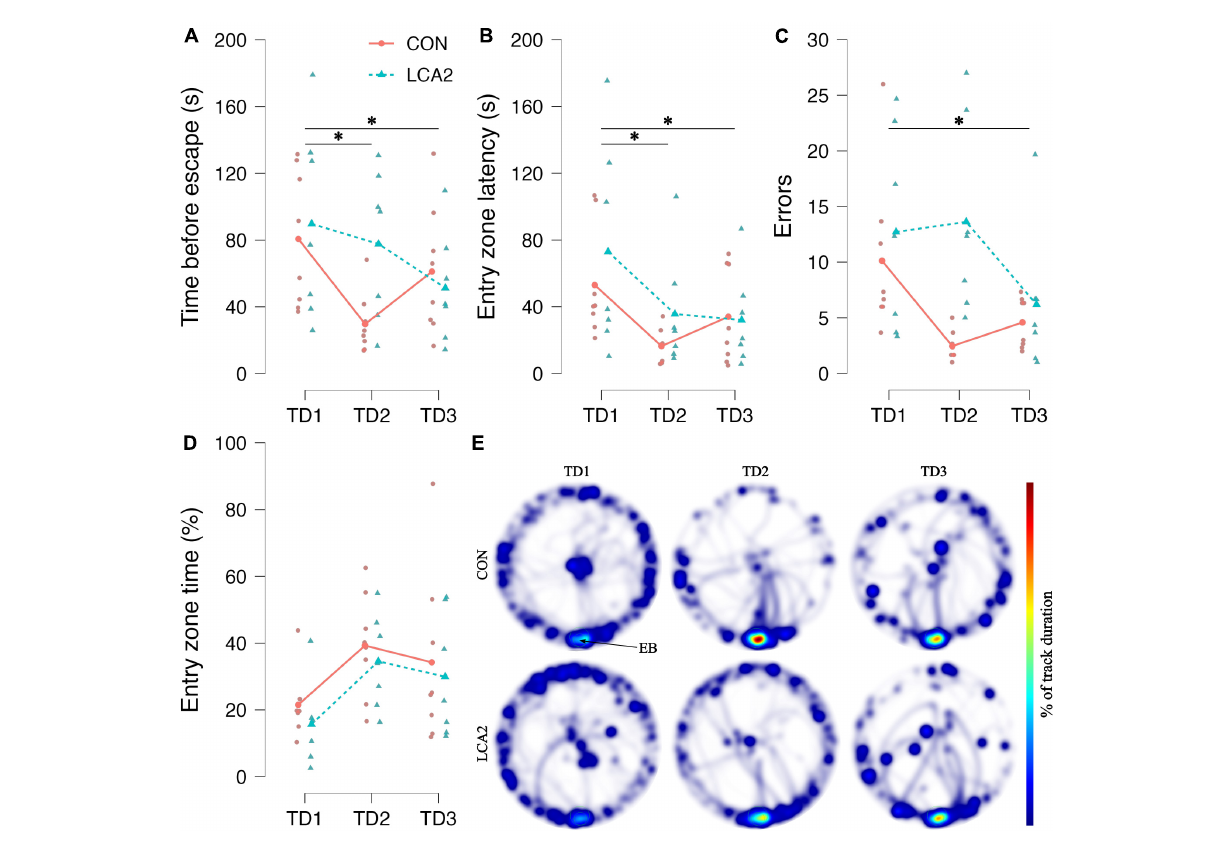
FIGURE6 (A) The time before entering the escape box. Both groups showed the ability to learn across the TDs. However, the learning curve differed substantially through TD2, where LCA2 showed an increased latency to enter the escape box. TD1: CON = 81 s [95% CI (52, 108)], LCA2 = 90 s [95% CI (47, 132)], TD2: CON = 30 s [95% CI (17, 42)], LCA2 = 78 s [95% CI (45, 111)], TD3: CON = 61 s [95% CI (34, 88)], LCA2 = 51 s [95% CI (27, 76)]. (B) The time before the first visit to the entry zone around the escape box. Both groups reduced the latency to the first visit to the entry zone. TD1: CON = 53 s [95% CI (30, 76)], LCA2 = 73 s [95% CI (27, 119)], TD2: CON = 16 s [95% CI (9, 23)], LCA2 = 36 s [95% CI (10, 61)], TD3: CON = 34 s [95% CI (14, 54)], LCA2 = 32 s [95% CI (11, 53)]. (C) The number of visits to entry zones not containing the escape box. As for the latency to escape, the groups differed substantially on TD2. TD1: CON = 10.1 [95% CI (5.2, 15.1)], LCA2 = 12.7 [95% CI (6.0, 20.0)], TD2: CON = 2.5 [95% CI (1.6, 3.4)], LCA2 = 13.6 [95% CI (7.3, 20.0)], TD3: CON = 4.6 [95% CI (3.0, 6.1)], LCA2 = 6.2 [95% CI (1.5, 10.9)]. (D) The time spent in the entry zone relative to the total time spent. The LCA2 showed persistently less time spent in the entry zone through all TDs. TD1: CON = 20% [95% CI (12, 28)], LCA2 = 15% [95% CI (6, 25)], TD2: CON = 34% [95% CI (21, 48)], LCA2 = 28% [95% CI (16, 41)], TD3: CON = 30% [95% CI (11, 50)], LCA2 = 26% [95% CI (9, 43)]. (E) The average heatmaps for each group on the three TDs. The LCA2 group seems to spend less time getting into the escape box once discovered compared to the CON, which is seen to spend more time around the escape box. The color intensity of the heatmaps is scaled relative to the maximum observed value of 14%. The connected dots represent group means, while the faded, smaller dots are individual observations. EB, escape box; TD, training day. CON = two saline injections ( n = 8), LCA2 = two DSP-4 injections ( n = 7).